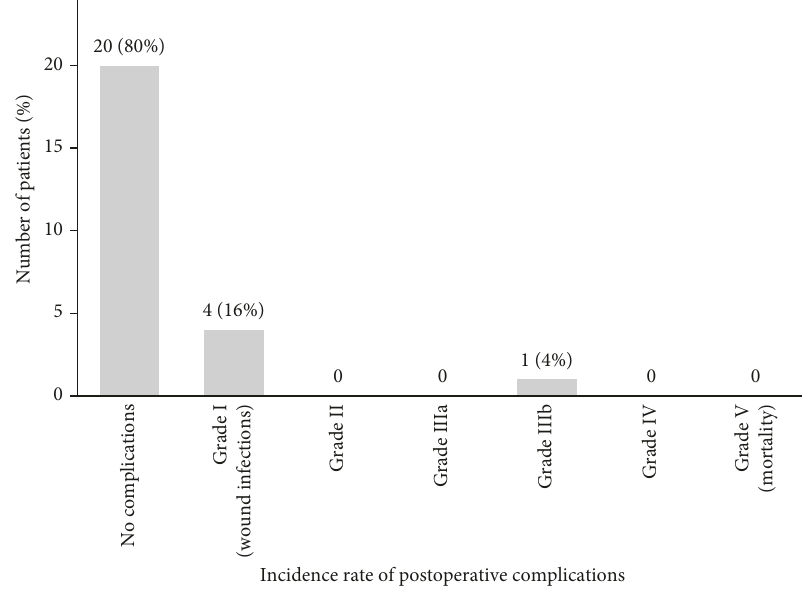
Figure 2: The rate of postoperative complications within 30 days after the surgery in the high-risk